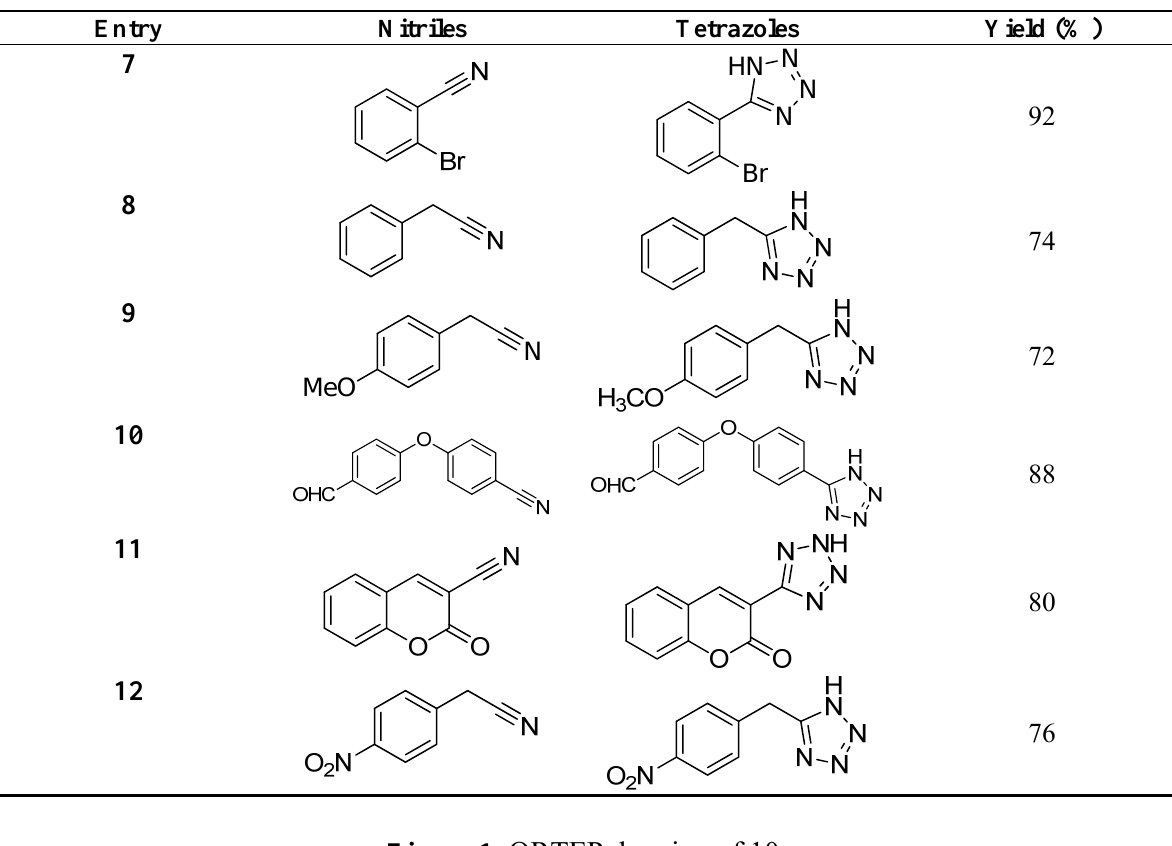
Figure 1. ORTEP drawing of